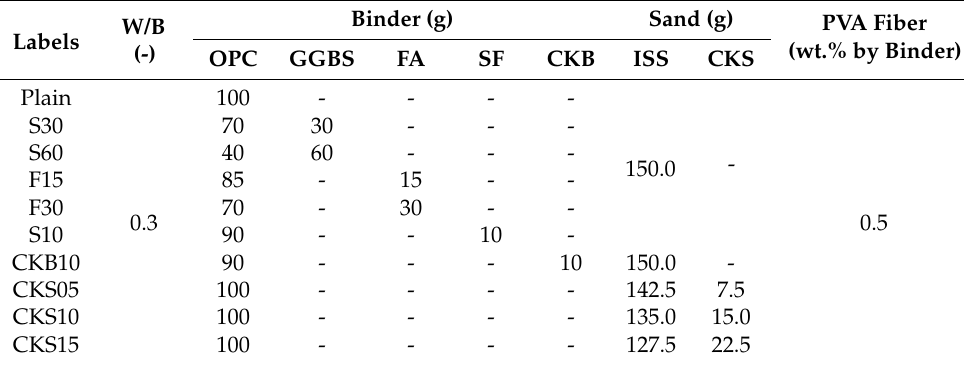
Table 2. Mixture proportions of mortar specimens.